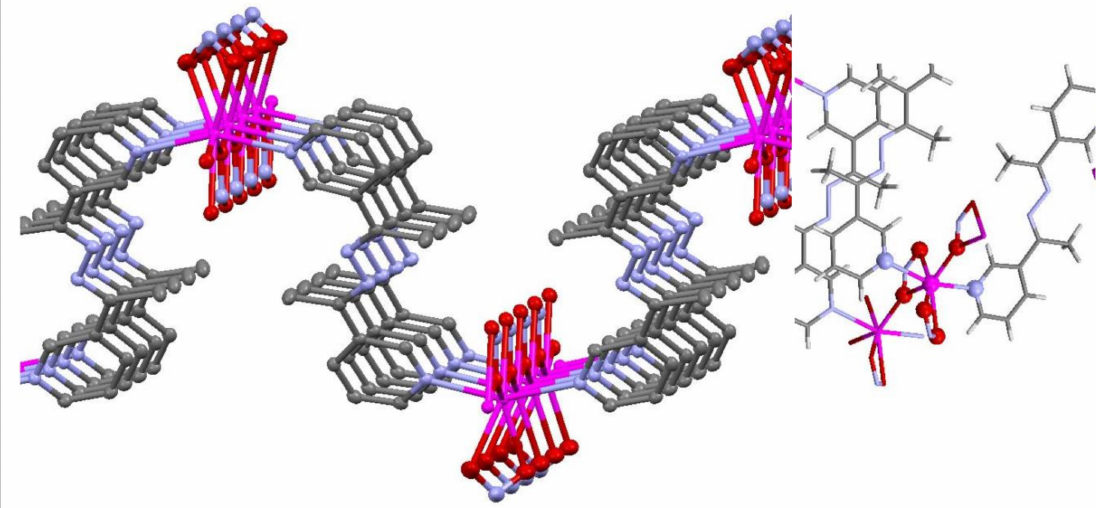
Figure 5. The coordination polymer fragment showing the 2D arrangement of complex (Left), The coordination sphere of Cd(II)